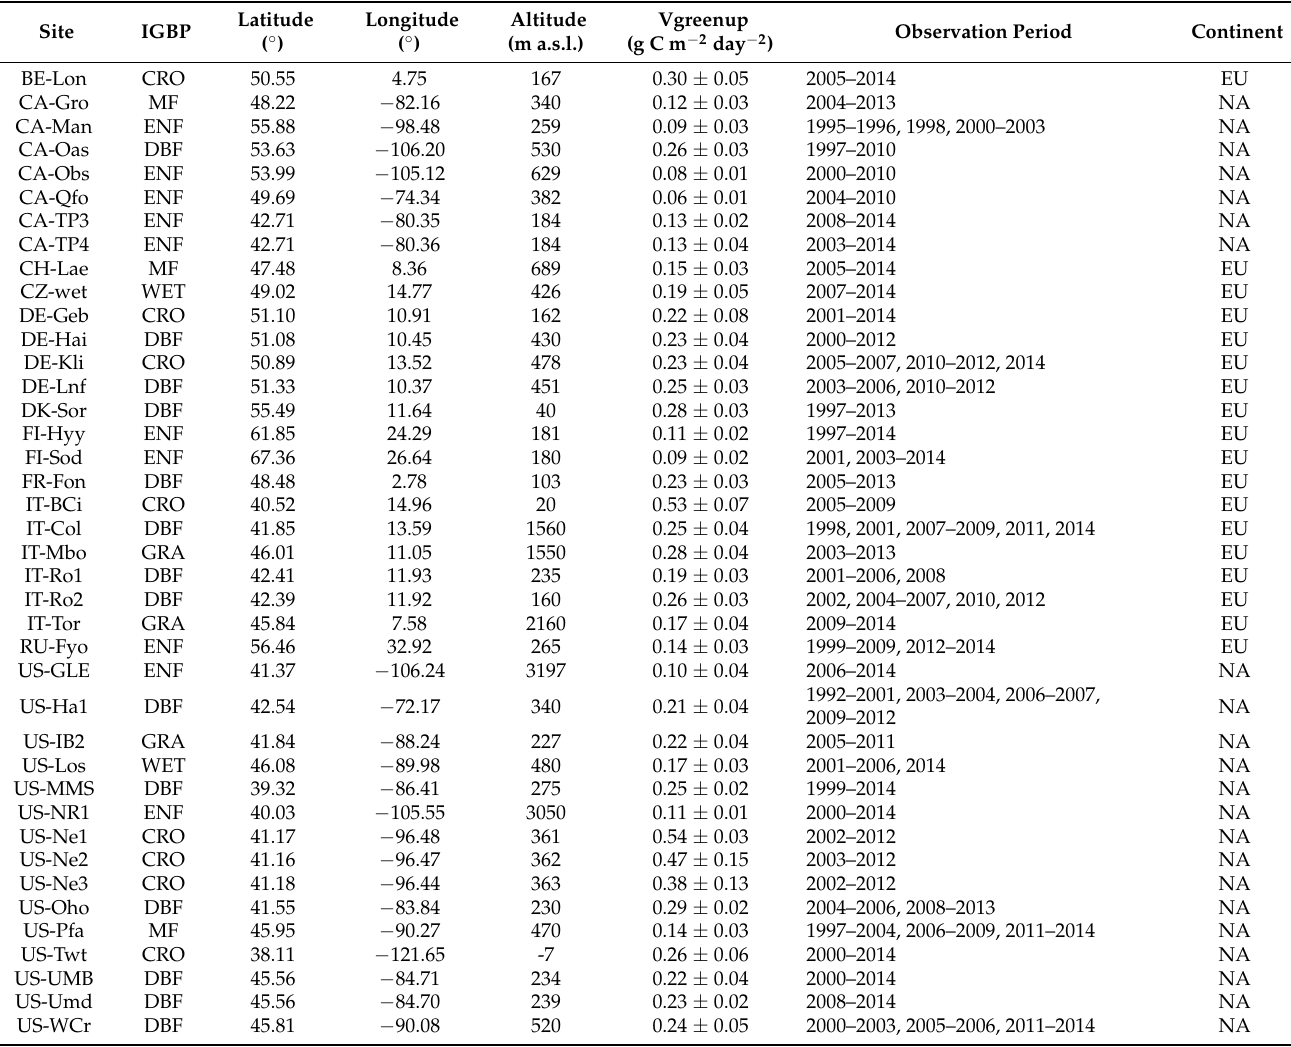
Table 1. Statistics of Vgreenup for each site used in this study.